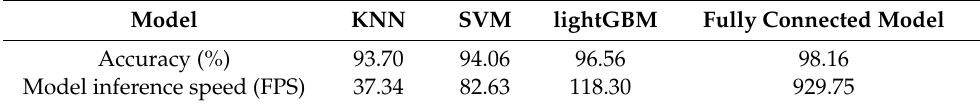
Table 7. Performance comparison of statistical learning models and fully connected model.